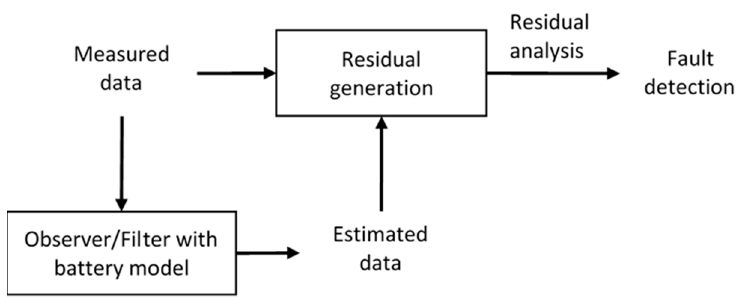
Figure 4. A simplified schematic of state estimation fault diagnosis.